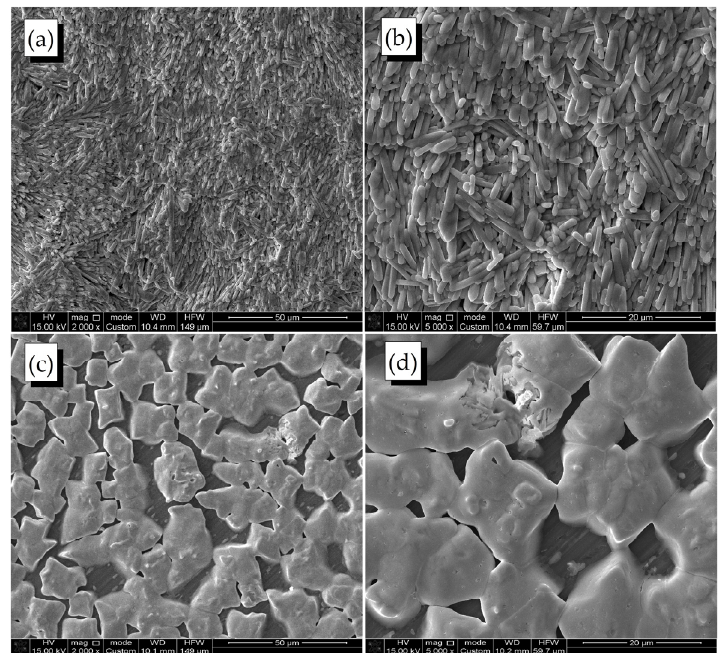
Figure 4. Scanning electron microscope images of the perovskite films spin-coated at different speeds (before and after atmospheric degradation): ( a ) before, (magnification 2000×); ( b ) before, (magnification 5000×); ( c ) after atmospheric degradation, (magnification 2000×); ( d ) after atmospheric degradation, (magnification 5000×).